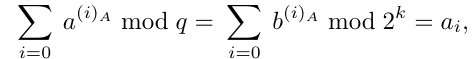
( x, 1) = Compress s q